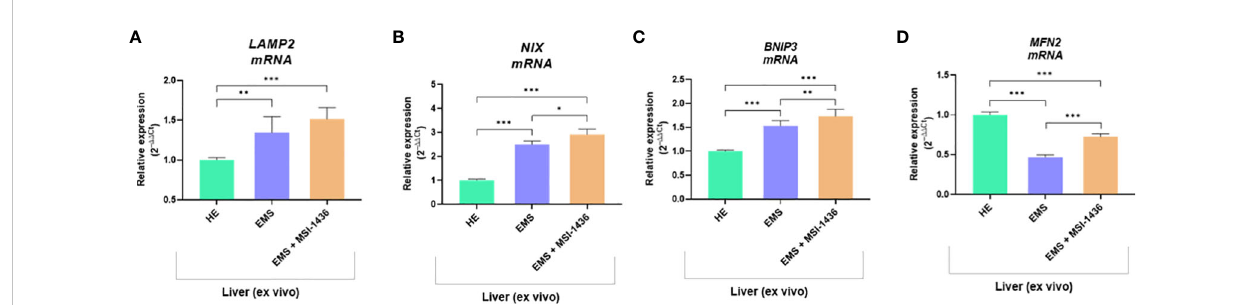
FIGURE 4 The transcripts levels associated with mitophagy determined with RT-qPCR. The comparative analysis included an evaluation of mRNA expression for LAMP2 (A) , NIX (B) , BNIP3 (C) and MNF2 (D) . Data are presented as a mean value obtained from measurments ± SD. Statistical signi fi cance was marked as follows: *p-value < 0.05, **p-value < 0.01 and ***p-value <